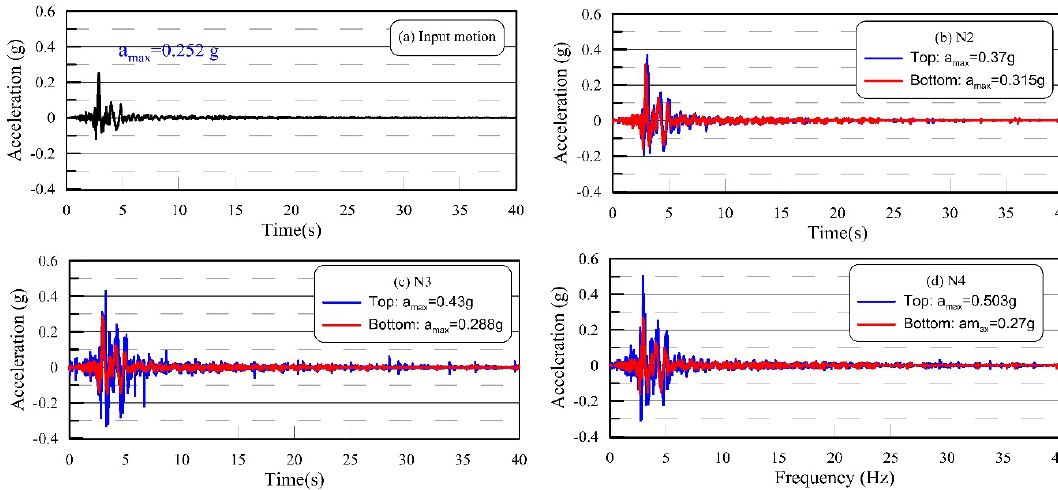
Figure 24. Acceleration responses of the observed nodes in the analysis: (a) input motion, (b) node N2, (c) node N3, and (d) node N4.